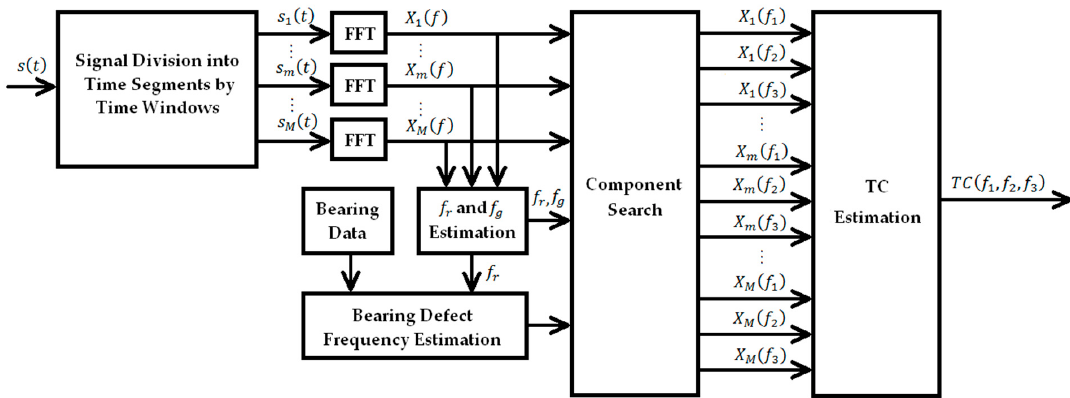
Figure 1. Block diagram for data processing for TC estimation.